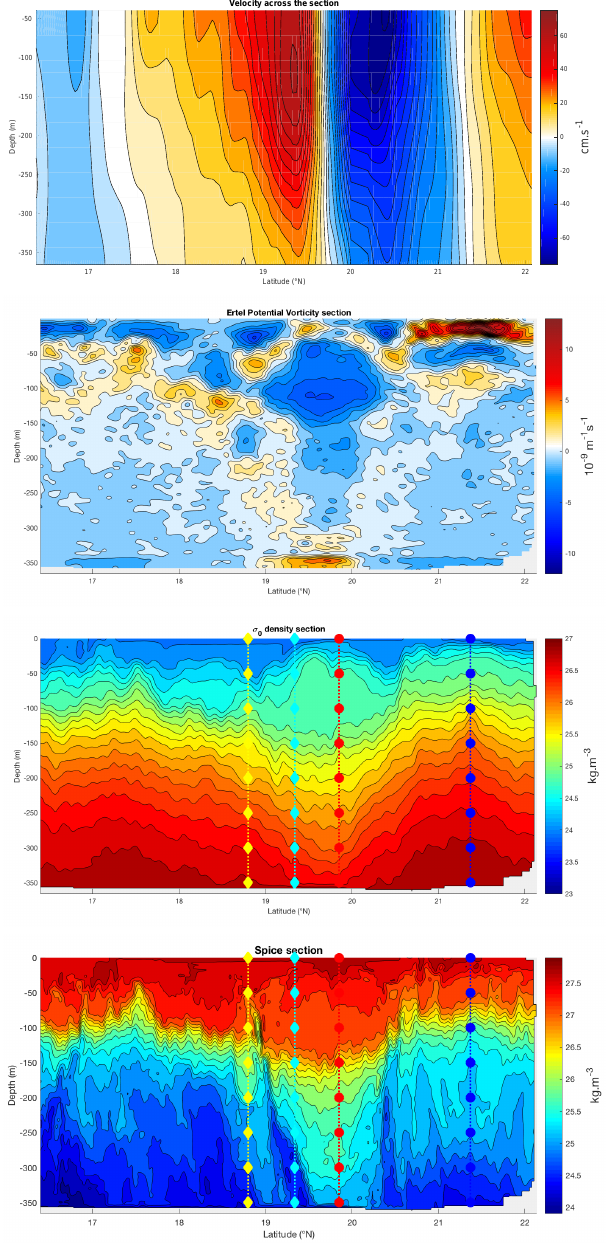
Figure 6. AS sections of the eddies, south of Ra’s Al Hadd from the surface down to 350m depth. Measurements and derived quan- tities are VM-ADCP velocities, positive towards the north; the Ertel potential vorticity anomaly is derived from VM-ADCP and SeaSoar fields; σ 0 potential density and spice. Profiles sampled in Fig. 8: yel- low diamond: salty injection around anticyclone A2; cyan diamond: fresh injection around anticyclone A2; red circle: inside anticyclone A2; blue circle: inside cyclone